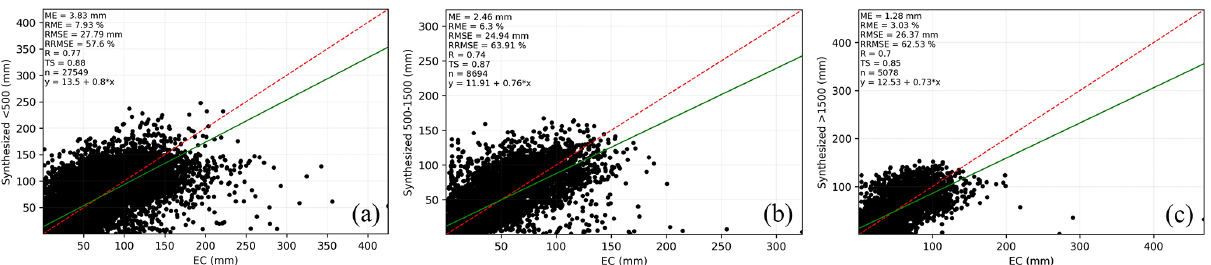
Figure 18. Monthly synthesized ET against flux EC ET aggregated for all sites for each elevation level ( < 500m: a ; 500–1500m: b ; > 1500m: d